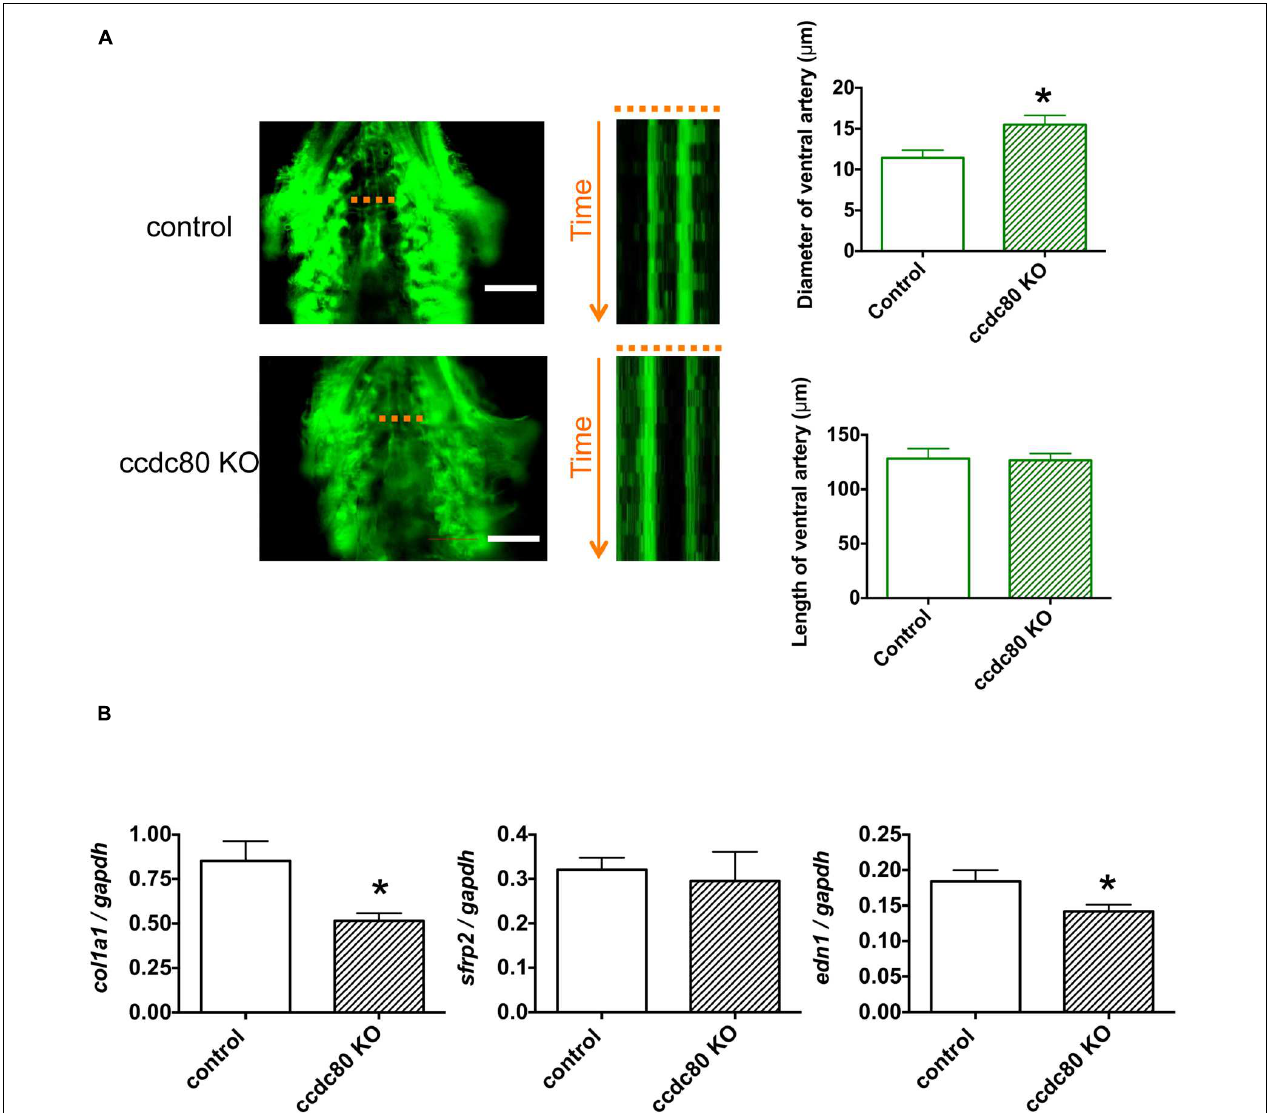
FIGURE 4 | Knockout of ccdc80 causes ventral artery dilation and decreases col1a1 and edn1 expression in zebrafish. (A) In vivo imaging of the ventral artery of control and ccdc80 knockout Tg (fli1:EGFP) zebrafish at 6 dpf. Zebrafish were placed on slides on their backs, and the ventral artery was imaged under a fluorescence microscope at 100 frames/s for 5 s. Image stack projections and time-lapse imaging traces at the level of the ventral artery (dotted lines) are shown. Bar, 100 µ m. The ventral artery diameter of the ccdc80 knockout zebrafish was significantly larger than that of control, whereas the length of ventral artery was not significantly different between groups. The upper right bar graph shows quantification of ventral artery diameters measured using time-lapse imaging. The lower right bar graph shows quantification of ventral artery lengths. N = 6 or 9 for the control and ccdc80 knockout groups, respectively. ∗ p < 0.05 vs. control. (B) qPCR analysis of col1a1 , sfrp2 , and edn1 mRNA levels in control and ccdc80 knockout zebrafish at 6 dpf. Expression of col1a1 , sfrp2 , and edn1 was normalized to that of gapdh . N = 8 per group. ∗ p < 0.05 vs. control